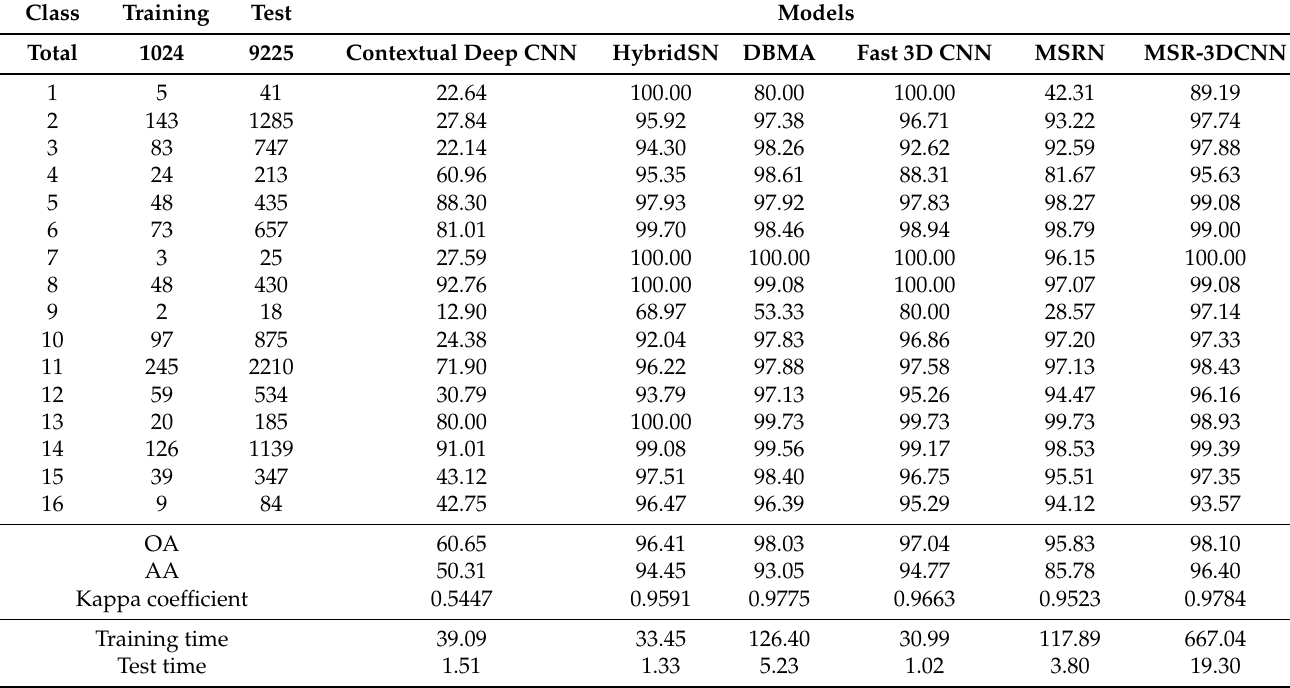
Table 4. F1 Score (%) for each class OA (%), AA (%), and Kappa coefficient values for the entire dataset, training time (s), and test time (s) using ( 9 × 9 ) patch size and 10% samples for training on the IP